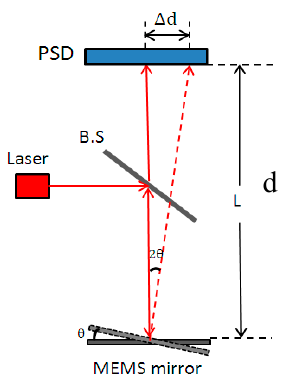
Figure 9. Experimental setup for measuring the mirror tilt angle.